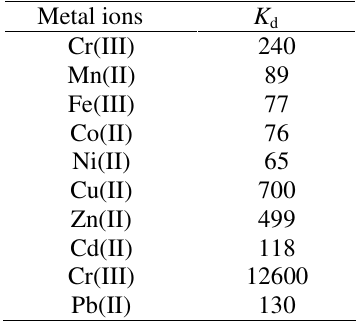
Table 3. Percentage removal of Cr(III) ) d